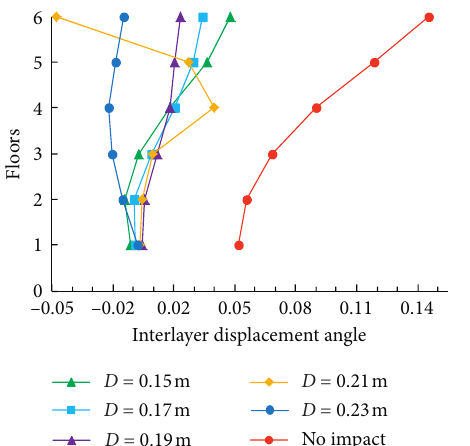
Figure 15: Variation curve of KJ-B interlayer displacement angle under different gap sizes (PGA �